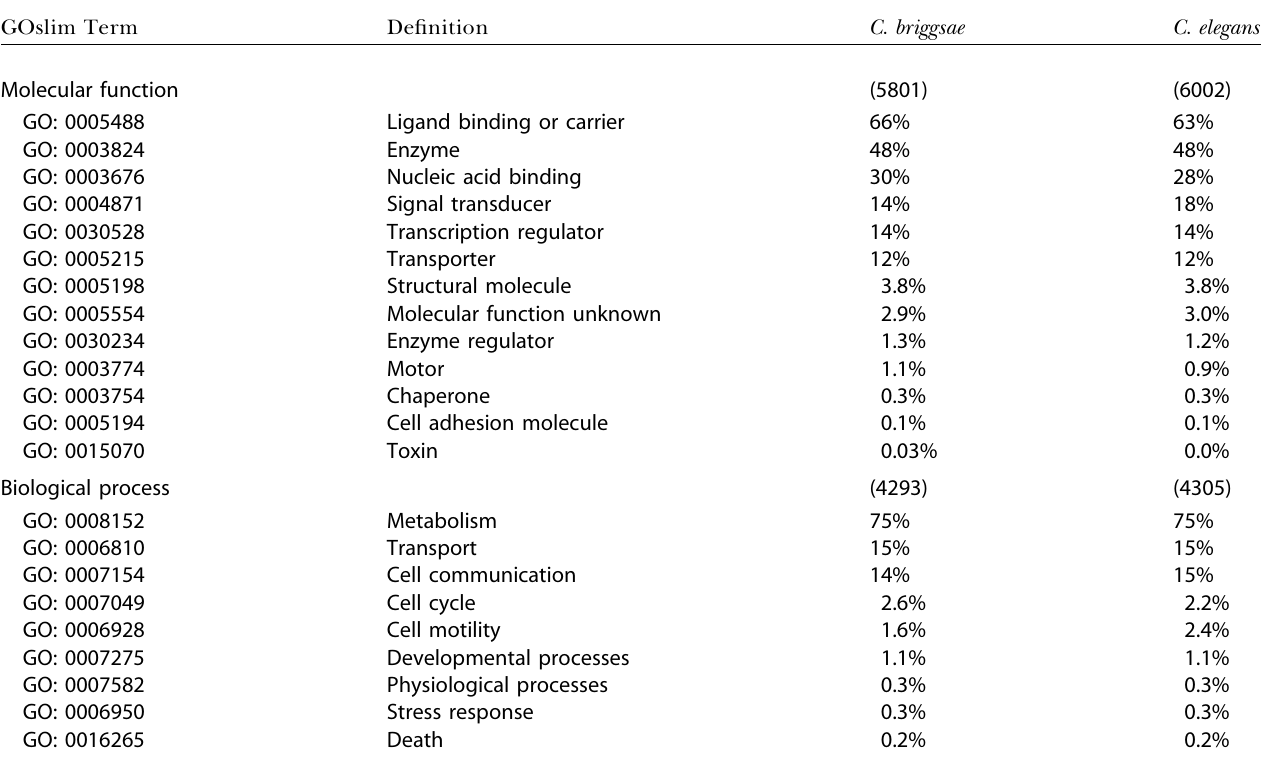
Table 2. Classification of Predicted C. briggsae and C. elegans Proteins into GOslim Categories GOslim Term